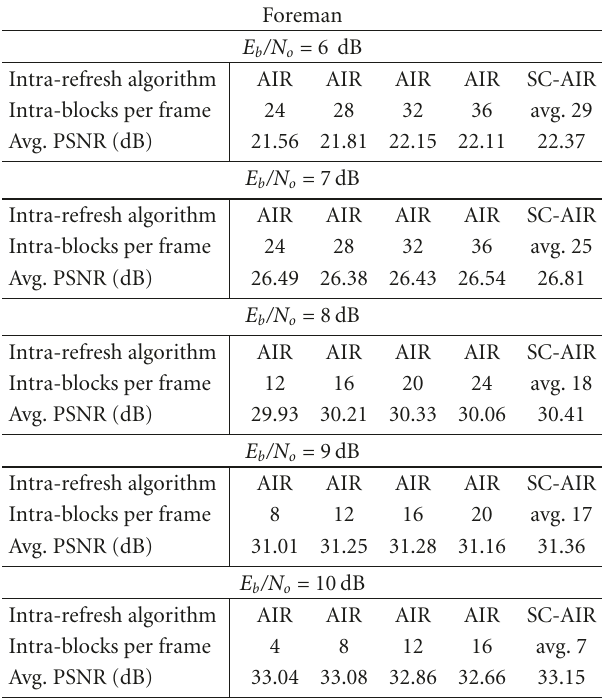
Figure 9: Subjective test results of the 90th frames of the transcoded “Foreman” stream for E b /N o = 9dB: (a) error-free; (b) No ER; (c) HEC + VPR; (d) HEC + VPR + DP; (e) HEC + VPR + DP + 10AIR. Table 2: Transcoding test results for the “Foreman” stream using standard AIR and